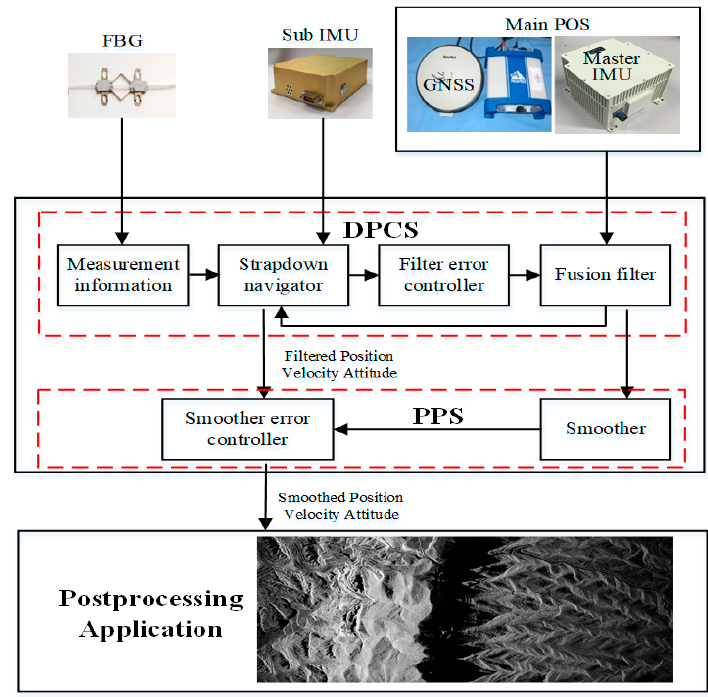
Figure 2. The components and principle of DPOS base on FBG.